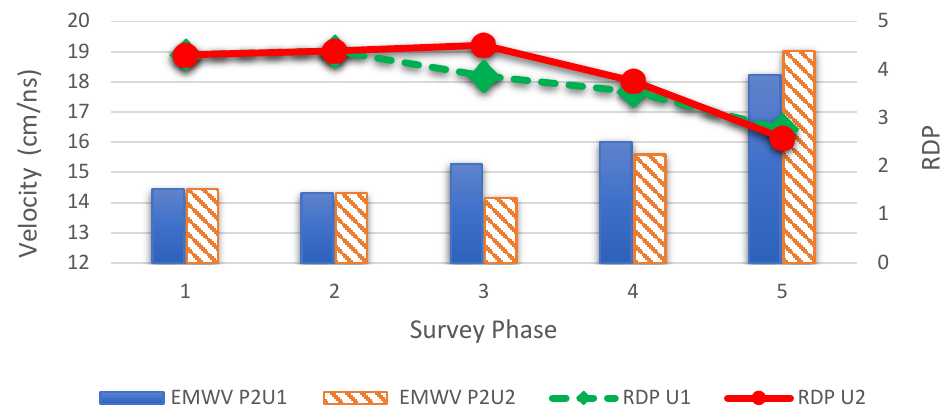
Figure 9. The change of Electromagnetic Wave Velocity (EMWV) and RDP values during the lifecycle of the railway track in section P2.